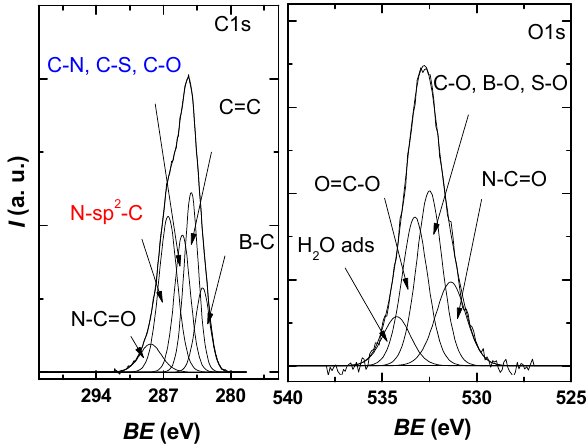
Figure 5. C1s and O1s XPS high-resolution spectra for the investigated sample, each with the deconvolution into characteristic components.